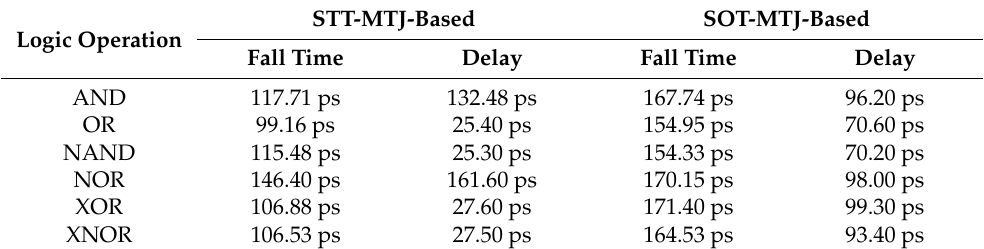
Figure 6. Waveform showing the operation of spintronics PGs. Table 2. Maximum fall time and delay of spintronics